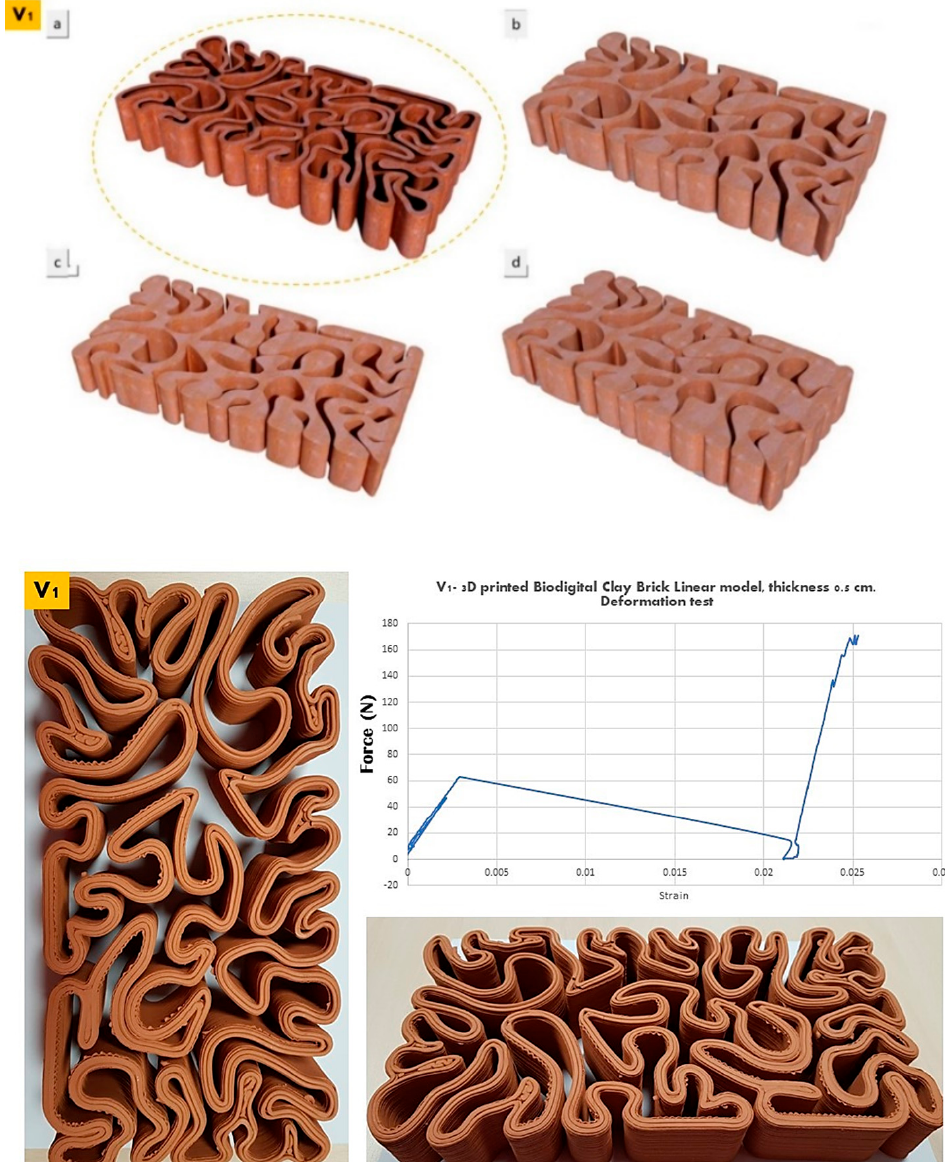
Figure 6. Exhibits the linear brick model of the V1 family of the biodigital clay bricks with double line linear thickness of 0.5 cm in 3D renders ( top ) as ( a ) id the tested linear brick model while ( b – d ) are the bulk models of the same family with variant densities. and in physical 3D-printed model ( bottom ). The graph exhibits the results of the deformation test for this brick, showing the relation between force (N) ( Y -axis) and strain ( X -axis). By excluding the nonuniform cross-section area, the relation between F and (cid:78) L gives an indicator of the overall elastic behaviour of the brick. The V1 linear model achieved its highest strain under 60 N with strain of 0.0025 pre-cracking and significantly increased elasticity post-cracking, reaching 0.025 strain under 170